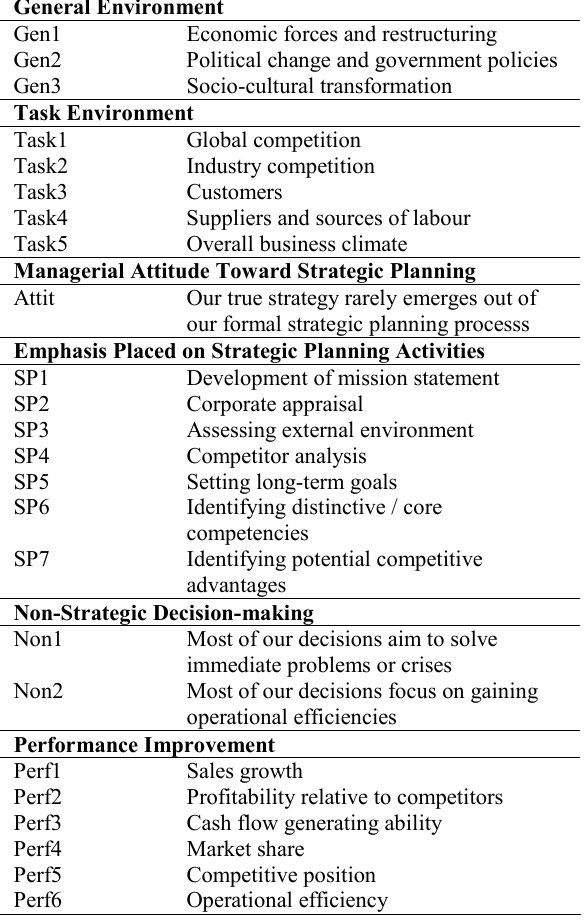
Table 1: Constructs and